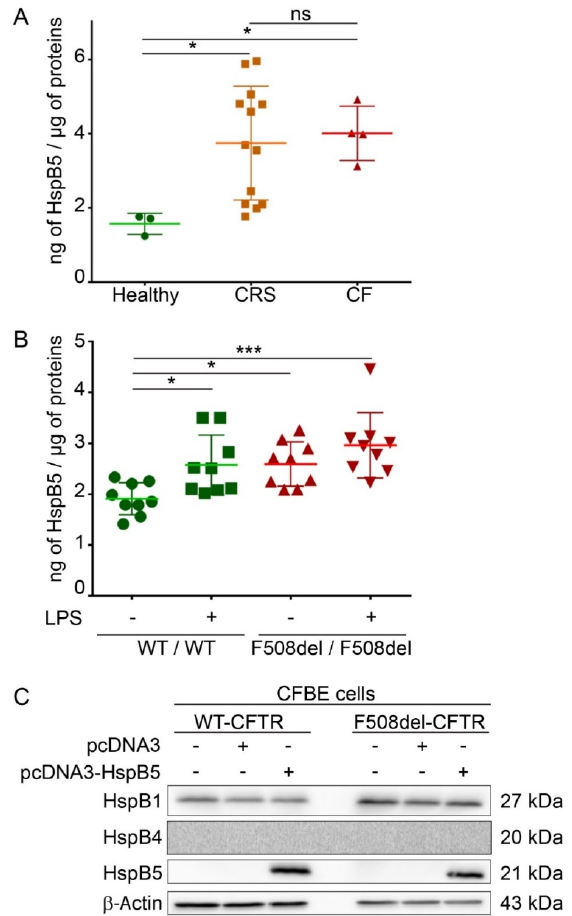
Figure 1. Endogenous expression of HspB5 in different Cystic Fibrosis (CF) models. Measurement of